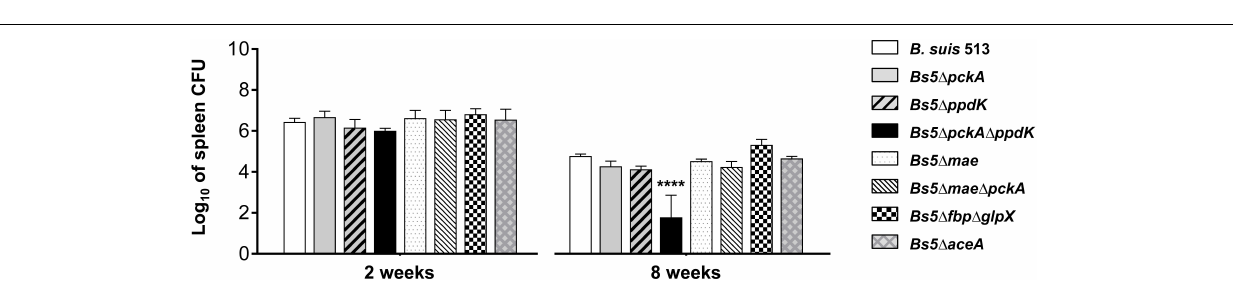
FIGURE 7 | Bacterial loads in the spleens of BALB/c mice at 2 and 8 weeks post-infection of B. suis 513 and mutants Bs5 (cid:49) pckA , Bs5 (cid:49) ppdK , Bs5 (cid:49) pckA (cid:49) ppdK , Bs5 (cid:49) mae , Bs5 (cid:49) mae (cid:49) pckA , Bs5 (cid:49) fbp (cid:49) glpX , and Bs5 (cid:49) aceA . Statistical differences with B. suis 513 were significant at week 8 for Bs5 (cid:49) pckA (cid:49) ppdK ( ∗∗∗∗ p ≤